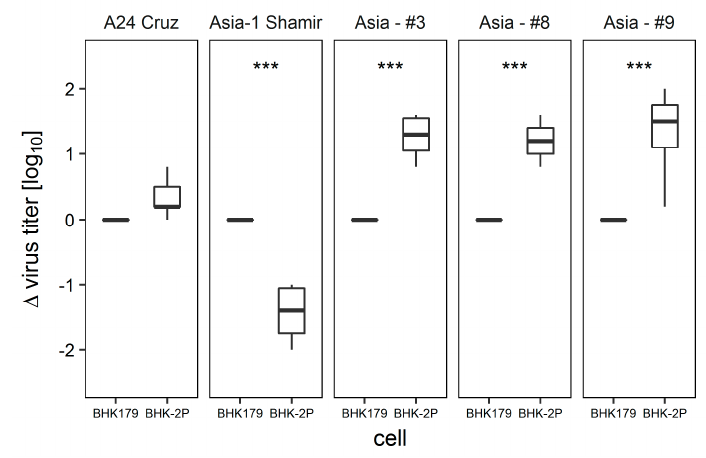
Figure 5. Infectivity after attachment of A 24 Cruzeiro, Asia-1 Shamir and adapted Asia-1 isolates to BHK179 or BHK-2P. The viruses were incubated either with the adherent cell line BHK179 or the suspension cell line BHK-2P for 15 min on ice to prevent internalization. Cells were washed to remove unbound virus and titrated. The y -axis shows the difference in titer between the BHK-2P and the BHK179 cell preparation. Experiments were performed in duplicates and repeated for a total of three times. Significance code: *** p < 0.001.